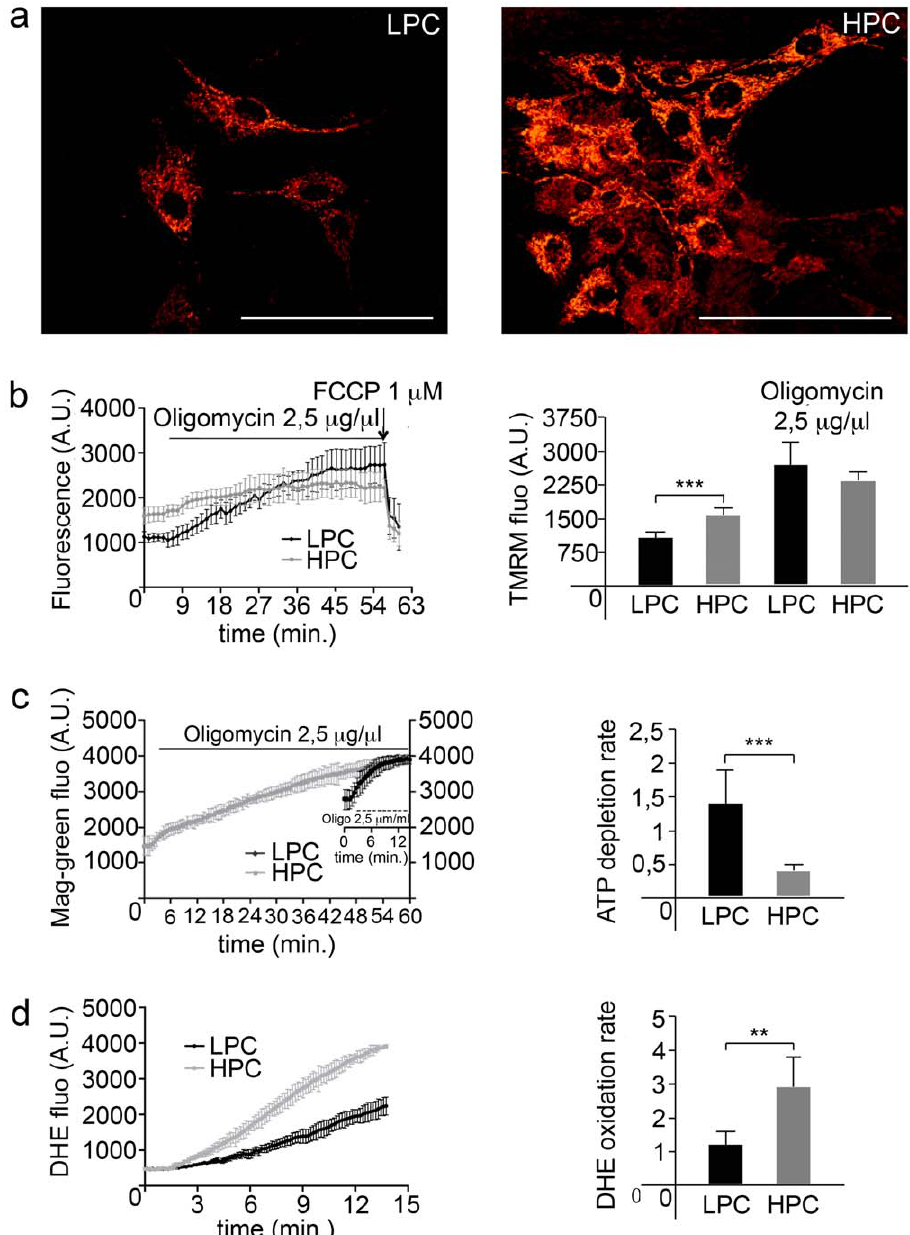
Figure 2. Metabolic characterization of Low and High Proliferative Clones. (a) Confocal images showing TMRM fluorescence as measurement of mitochondrial potential ( Dy m ). LPC (left) shows, in this culture condition, a lower Dy m compared to HPC (right). (b) Dy m was measured in real time in LPC and HPC using TMRM fluorescence and confocal imaging. Cells were treated with oligomycin (2.5 m g/ m l) to block the F O component of the F 1 F O -ATPasynthase. 1 m M FCCP was added at the end of each experiment to completely depolarize the mitochondria. Diagram on the left shows the trend over time. Values derived from 21 individual cells before and after oligomycin addition for LPC and HPC are summarized in diagram on the right (***p , 0.001). (c) Cellular ATP was followed in real time by measuring intracellular [Mg 2 + ] c using the fluorescent dye Magnesium Green (Mag-green). LPC and HPC were treated with oligomycin (2.5 m g/ m l) and (left) traces trend monitored over time (traces are mean 6 s.d. of 10 individual experiments for cell type); plotted values of [Mg 2 + ] c rate (mean 6 s.d.) is presented in diagram on the right (***p , 0.001). (d) ROS production was measured using 5 m g/ml dihydroethidium (DHE). Diagram on the left shows an increase in DHE fluorescence in LPC and HPC recorded in real time and diagram on the right the rate values (mean 6 SD) of three different experiments are summarized (**p , 0.005). doi:10.1371/journal.pone.0008523.g002 committed progenitors, both LPC and HPC are functional to maintain SCs niche. In our view this validates once more the high contribution to both muscle regeneration and self-renewal observed Fat deposition within muscle tissue is not present in physiolog- when different populations of SCs are transplanted either with their ical conditions and adipocytes are rarely seen in standard SC fiber [45] or as freshly isolated cells [46]. cultures, suggesting that the propensity of HPC cells to undergo